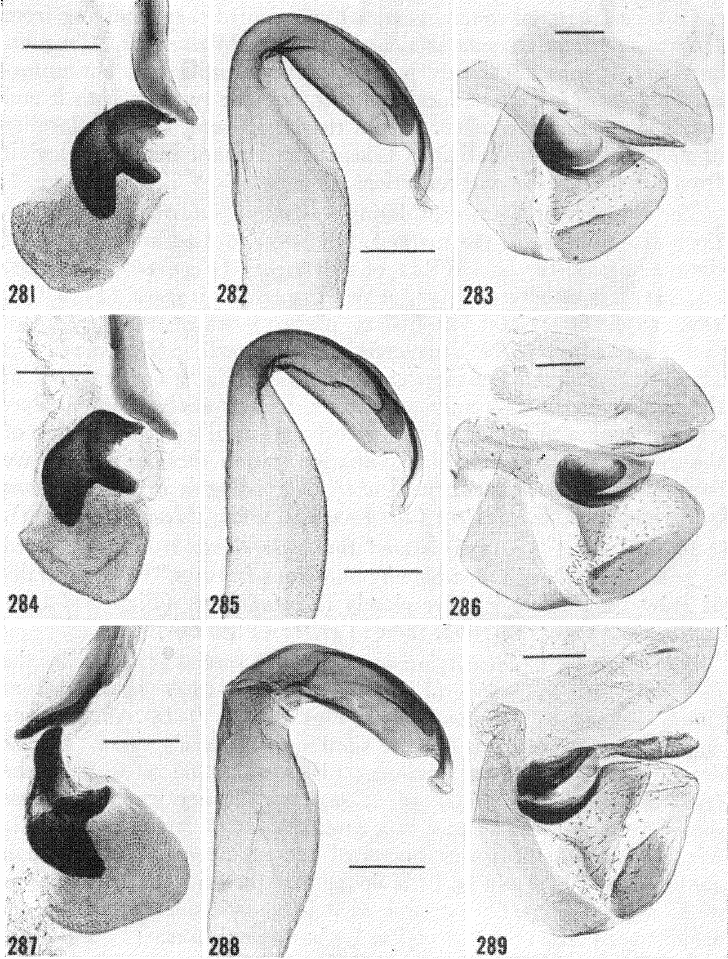
Figs. 281-289. Cockroach male genitalia. Epilampra sp. D. 281-283. (115 USNM). Turrialba, Costa Riea. 284-286. (133 USNM). Same data as Figs. 281-283 (281-286 det. as E. azteca by Prineis). 287-289. (139 USNM). Cerro Campana, Panama (det. Roth).